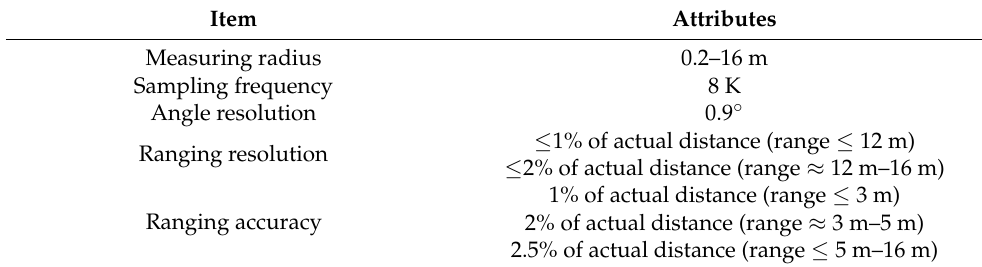
Table 1. Device parameters of Rplidar A2